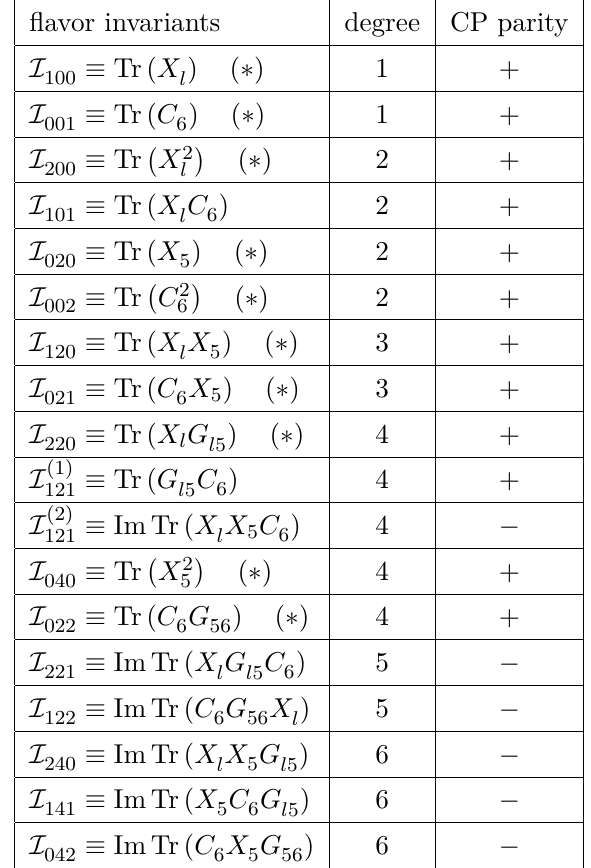
, G and ≡ C C † ≡ C X ∗ C † 5 5 5 5 5 l 5 l